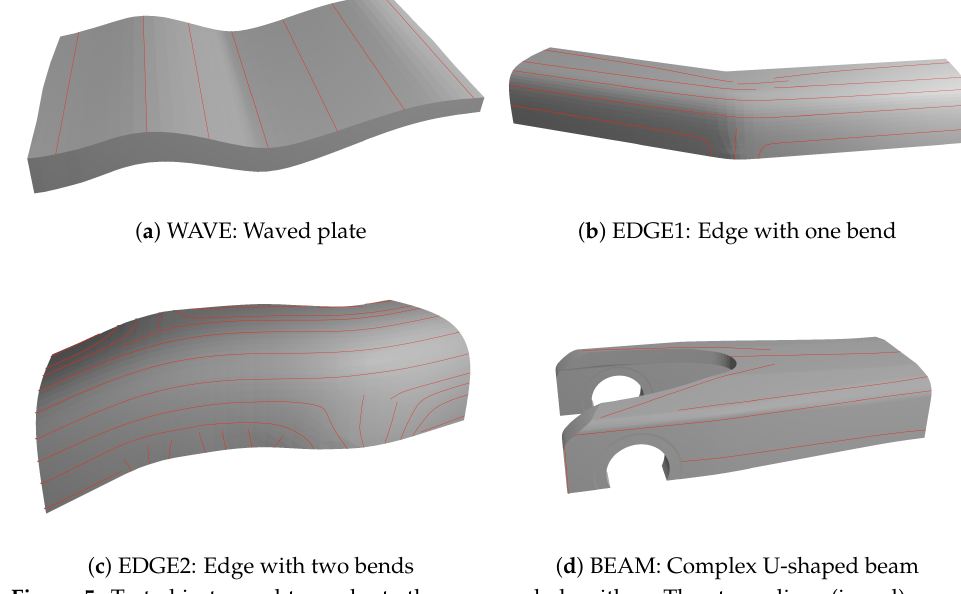
Figure 5. Test objects used to evaluate the proposed algorithm. The streamlines (in red) are gen- erated with the following variants of the algorithm (from top-left to bottom-right): papp-base-60 , papp-adaptive , papp-base-40 , papp-adaptive .